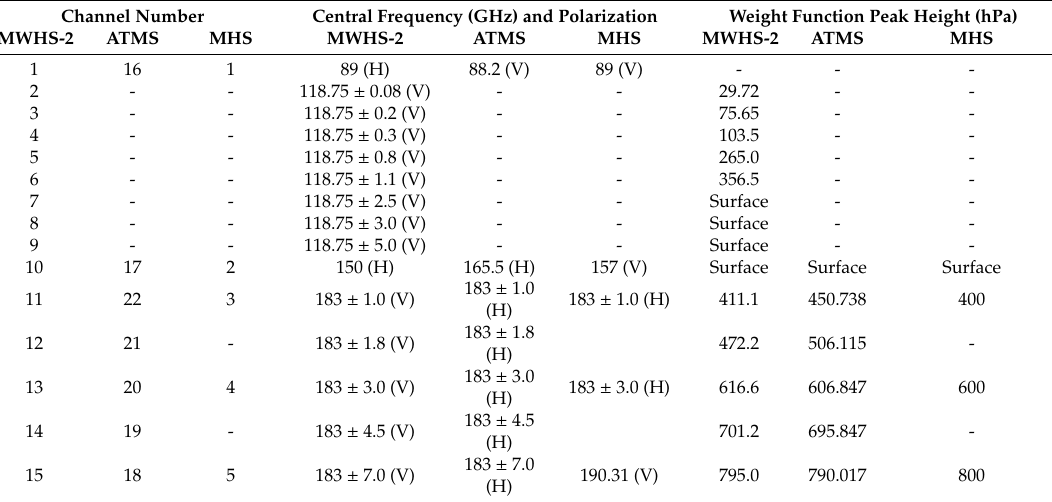
Table 1. Microwave Humidity Sounder-2 (MWHS-2), Advanced Technology Microwave Sounder (ATMS), and Microwave Humidity Sounder (MHS) channel numbers, central frequencies, polarizations, and weighting function peak